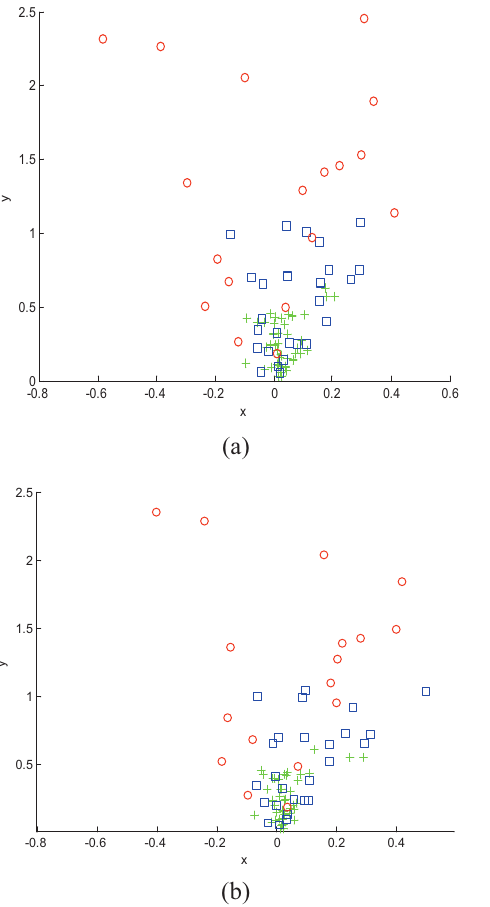
Fig. 6. Original metrics data and centers